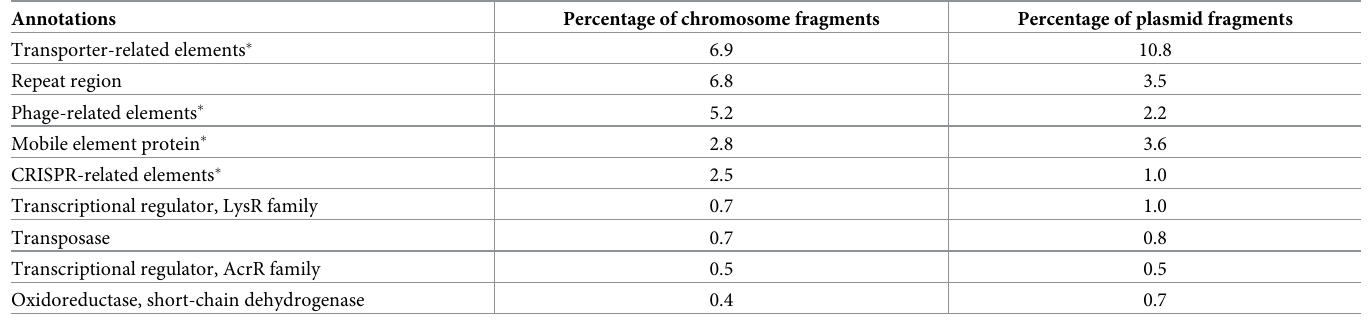
Table 3. The most commonly occurring annotations in sequence fragments with false